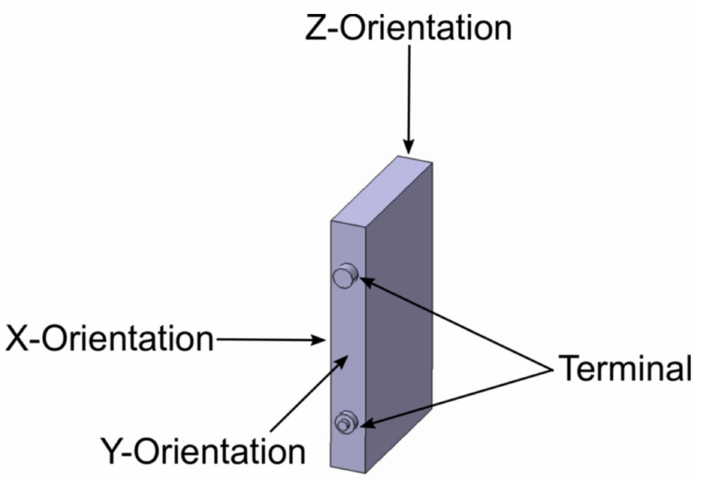
Figure 4. X-, Y- and Z-orientation of prismatic cell as per SAND2017-6925:2017